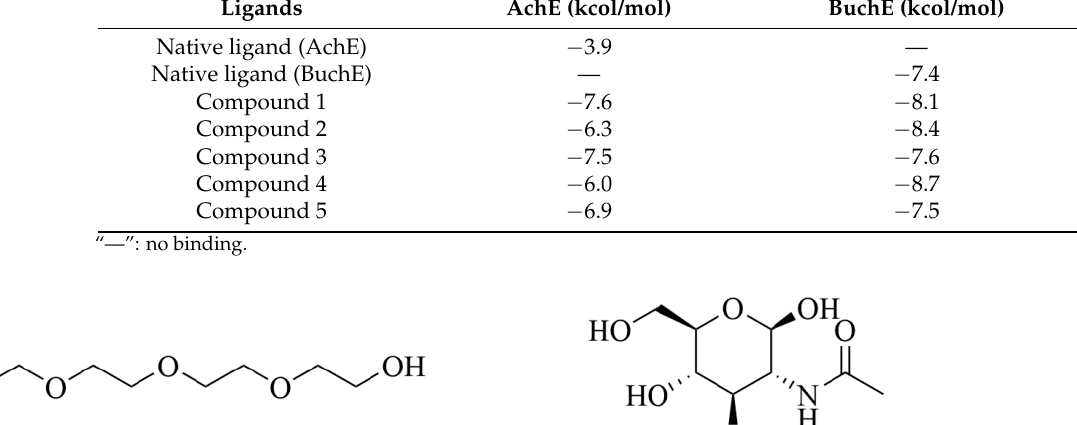
Table 3. Molecular docking of compounds 1 – 5 with AchE and BuchE.